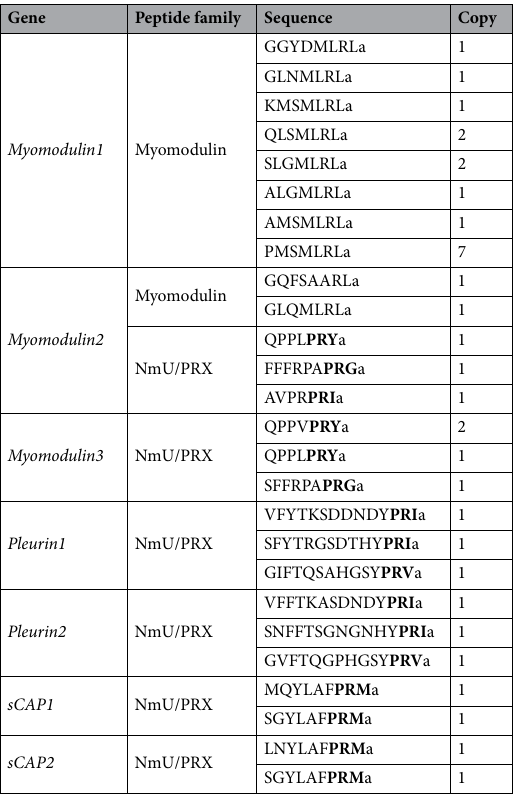
Table 1. NmU/PRXamide peptides predicted from the precursor genes in Deroceras reticulatum . The conserved C-terminal motif (-PRXamide) in NmU/PRXamide peptides is indicated with bold letters. The full- length prepropeptide sequences are found in the supplementary Figure